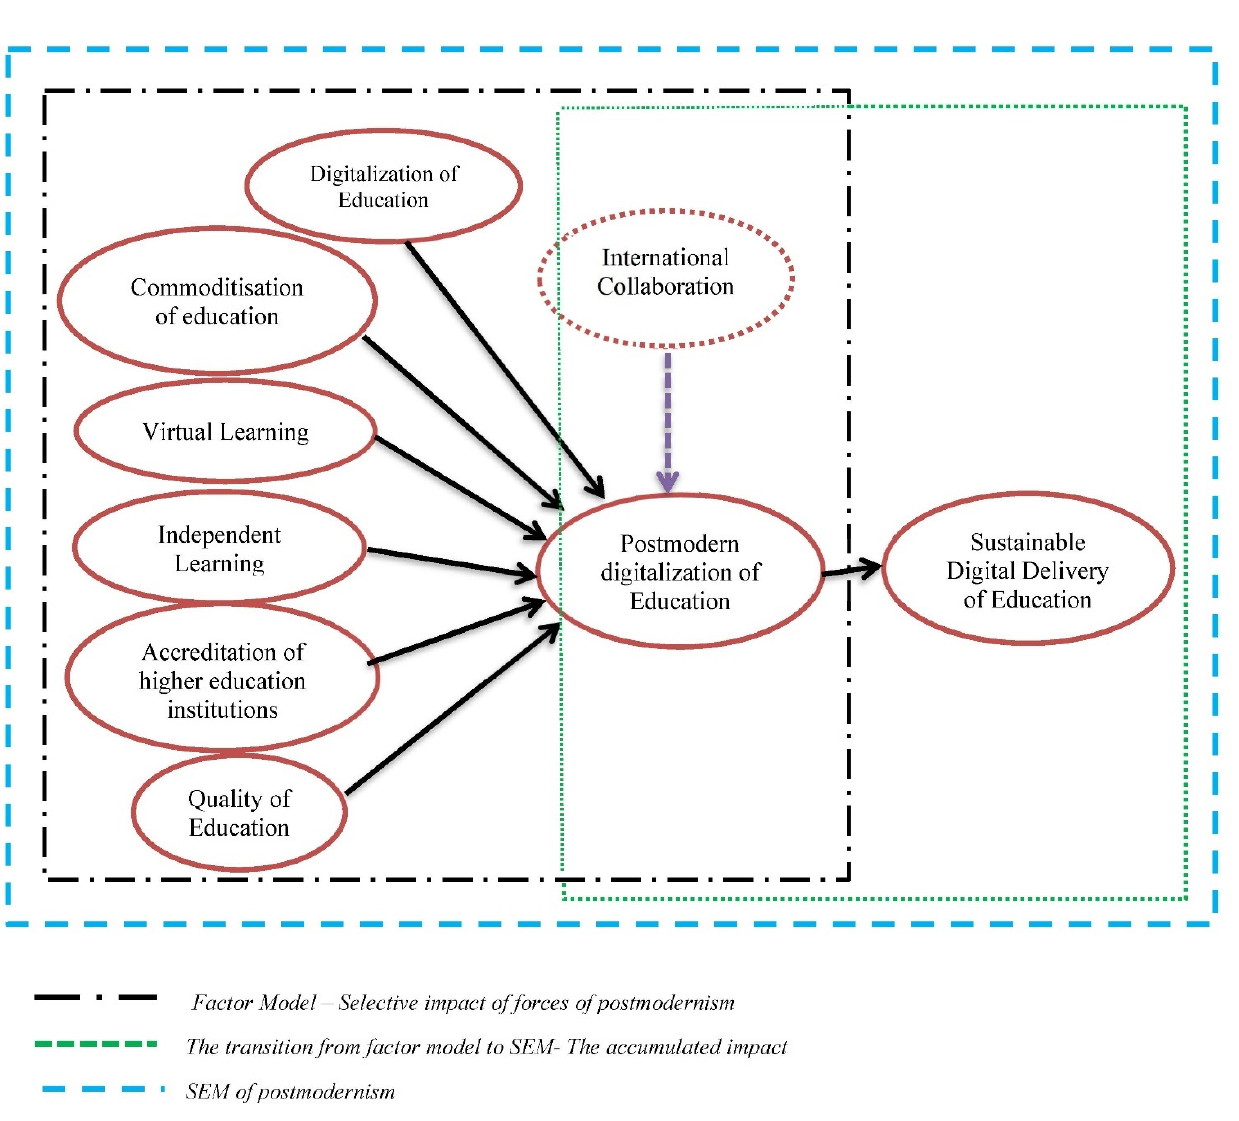
Figure 8. The measurements models and structural model of postmodern digital. Source: Based on Authors variable view.